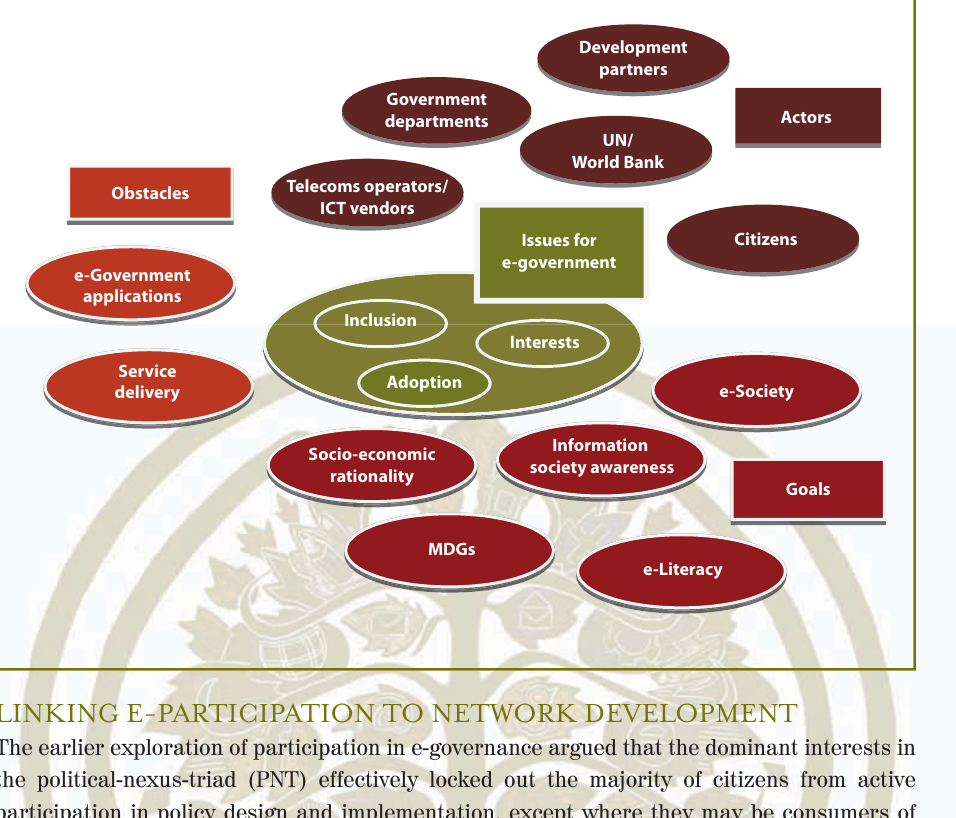
FIGURE 2: CONSTELLATION OF ACTORS, GOALS,